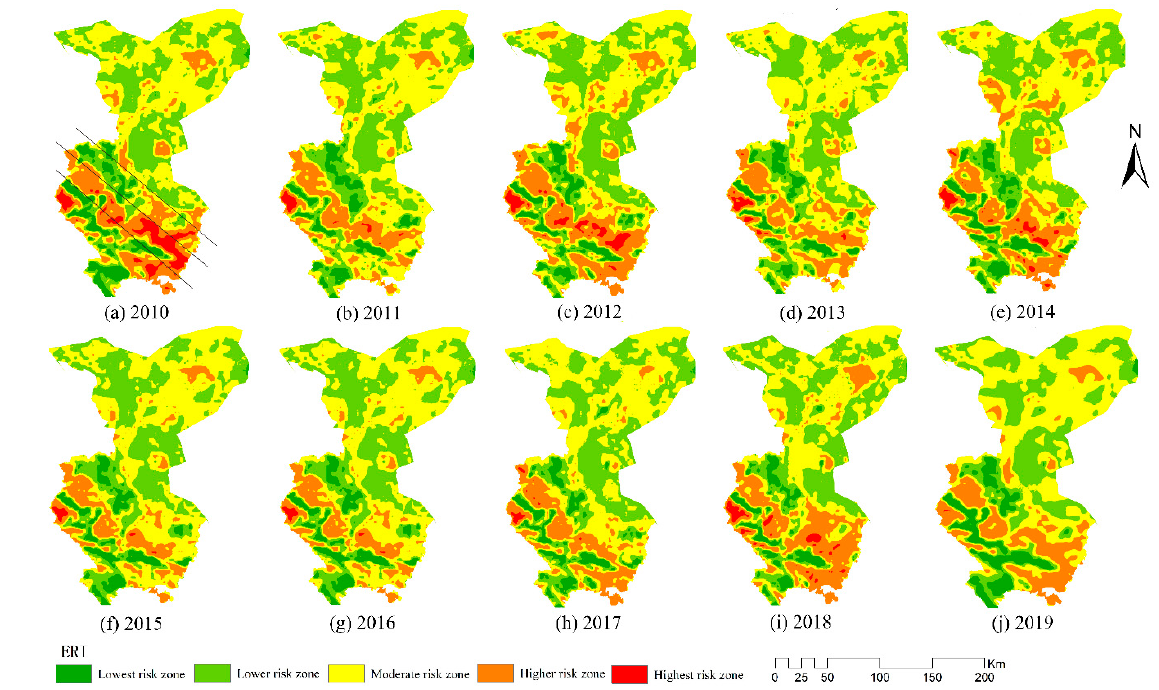
Figure 7. The distribution of ecological risks in 2010–2019.